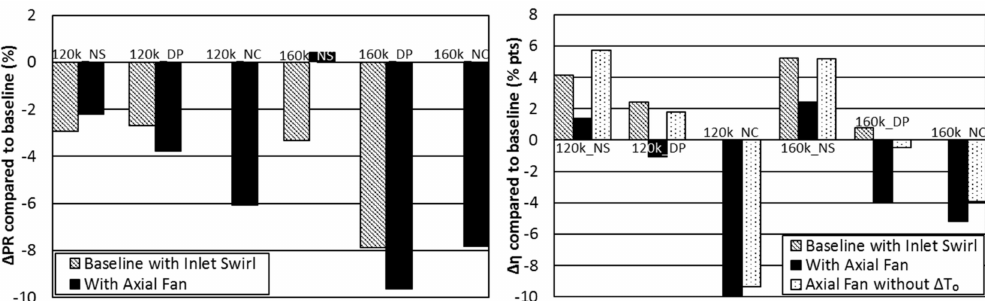
Figure 7. CFD predicted change in stage pressure ratio and efficiency relative to baseline at six operating points of interest. (Reproduced with permission from Taylor & Francis Group, ©2021